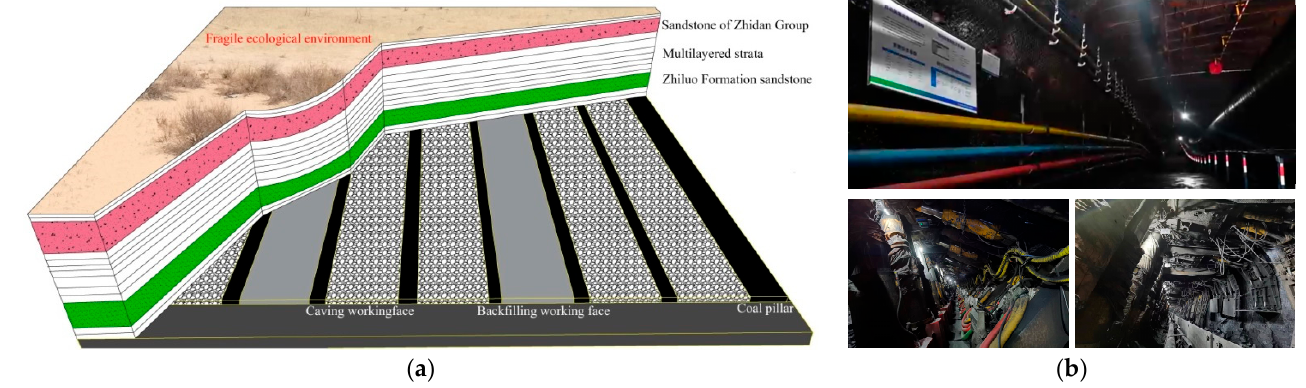
Figure 5. Local filling–caving multi-faces coordinated mining in deep areas; ( a ) schematic design. ( b ) Underground live.